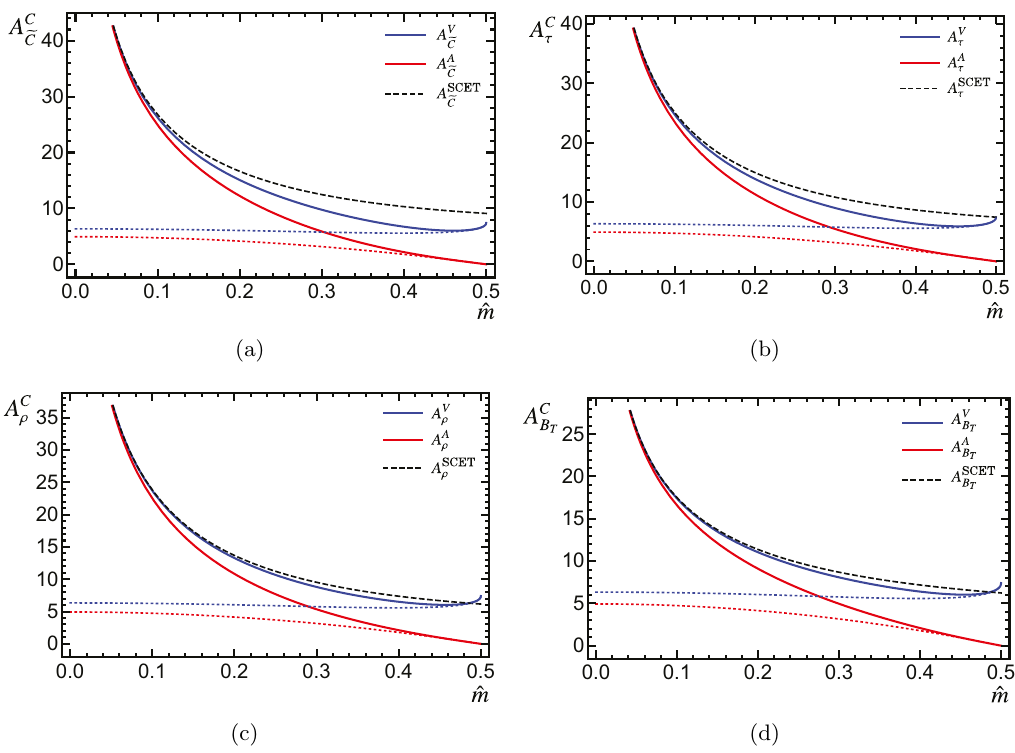
Figure 18 . The delta-function coe(cid:14)cients for reduced C-parameter, thrust, heavy jet mass and jet broadening (all in their original de(cid:12)nitions) as a function of the reduced mass ^ m . The red solid lines show the coe(cid:14)cients for an axial-vector current, the blue solid lines for a vector current. We also show the respective threshold limits as dotted lines, including terms up to O ( v 2 ). The SCET limit, shown as black dashed lines, coincides with the vector as well as axial currents for ^ m ! 0. The values in the threshold limit are universal, approaching 3 (cid:25) 2 = 4 and zero in the vector and axial-vector cases,